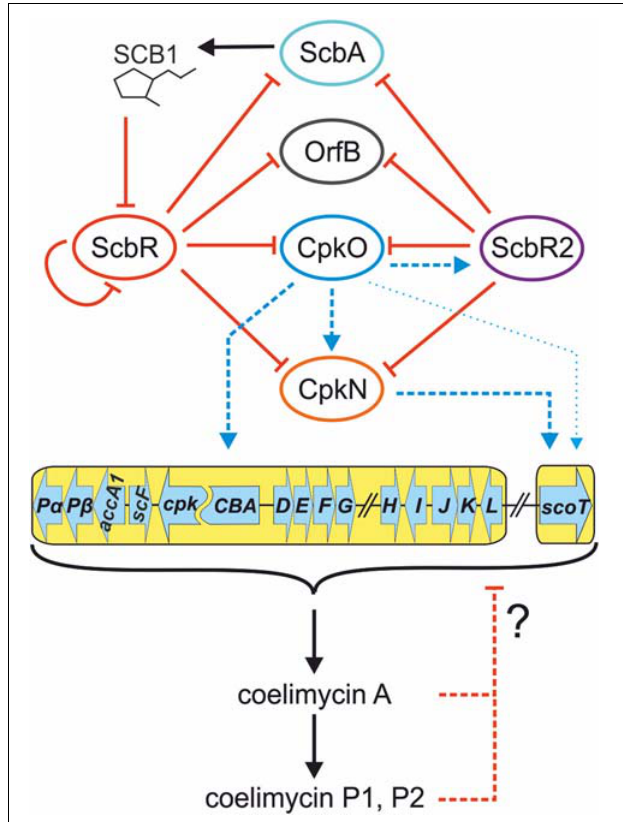
FIGURE 6 | Updated mechanism of coelimycin BGC regulation by cluster-situated regulators. Black arrows indicate γ -butyrolactone SCB1 and CPK production. Solid red lines ending with bars indicate inhibition of ScbR by SCB1 and direct repression by promoter binding. Dashed red lines indicate putative negative feedback loop exerted by coelimycin. Blue lines ending with arrows denote transcription activation. Thin blue arrow indicates weak activation of scoT transcription by CpkO independent from CpkN. Dashed lines imply an indirect or unknown regulatory mechanism (unknown binding site of the activator). CPK biosynthetic genes are marked with a yellow background. Regulatory genes are omitted from the cluster scheme for